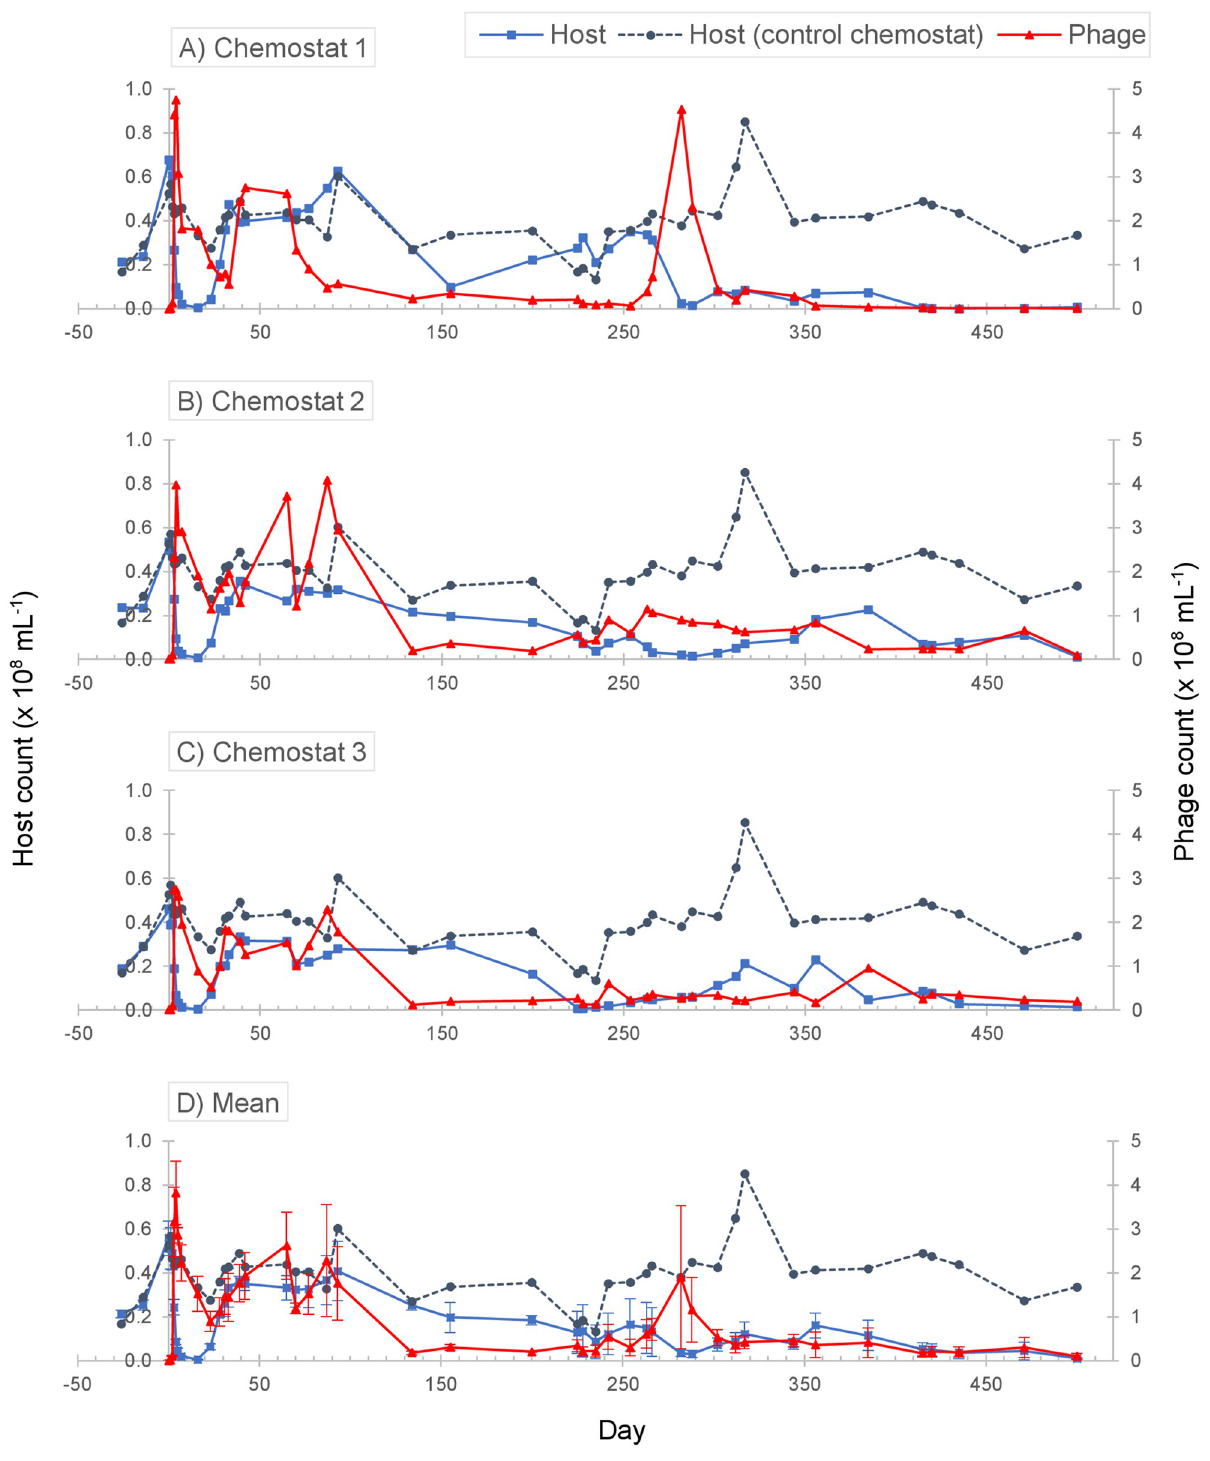
Fig 1. Host Synechococcus sp. WH7803 and cyanophage S-PM2d population dynamics. Abundances, specifically the flow cytometric (FCM) counts in 10 8 per mL, of the host ( ◼ ) and phage ( ▲ ) over the course of a 500-day (~55 bacterial generations) infection experiment, run parallel in three replicate chemostats 1–3 (panels A-C). Mean abundances across the three replicate chemostats (n = 3; error bar = SEM) are plotted in panel D. For reference, Synechococcus abundance in the control (phage-free) chemostat ( ⚫ ) is plotted in all four panels. Under steady-state throughout the experiment, the abundance of Synechococcus in the control chemostat averaged at 4.01 ± 1.28 x 10 7 mL -1 . Phage was added into the chemostat cultures on day 0, and the phage populations were sampled for genomic analysis on days 39 (‘early’) and 500 (‘late’) of the experiment. https://doi.org/10.1371/journal.pone.0281537.g001 PLOS ONE | https://doi.org/10.1371/journal.pone.0281537 February 9,